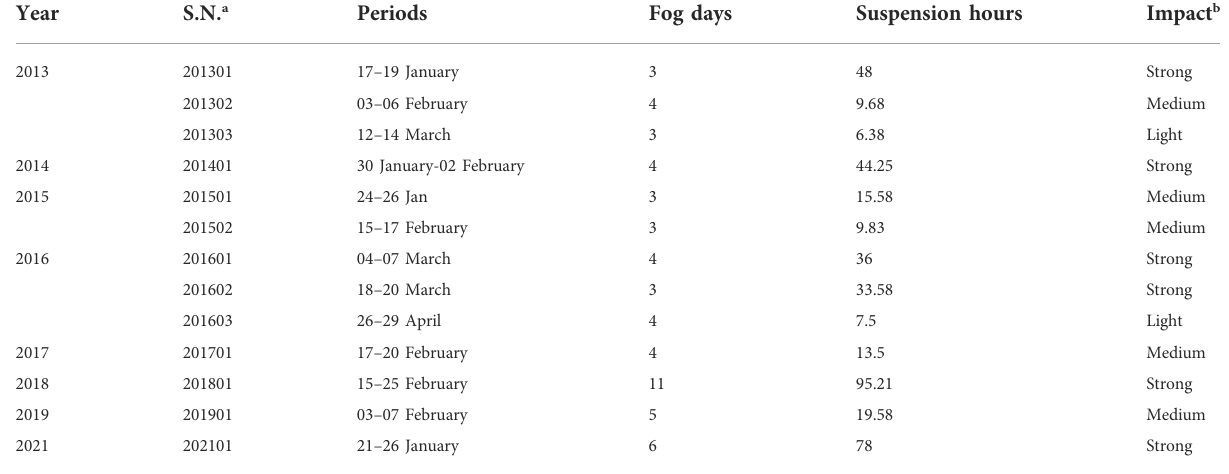
a S.N., means the serial number of the sea fog event. b Impact means the degree of in fl uence of the sea fog case. Strong: harbor suspension time due to sea fog exceeds 24 h; medium: suspension time is 8 – 24 h; light: suspension time less than 8